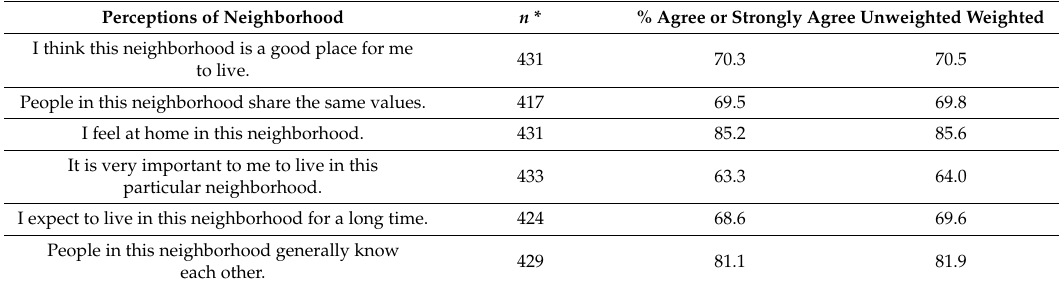
Table 4. Intention to move by residence in impact or bu ff er areas of GHIB ( n = 435, weighted percent).